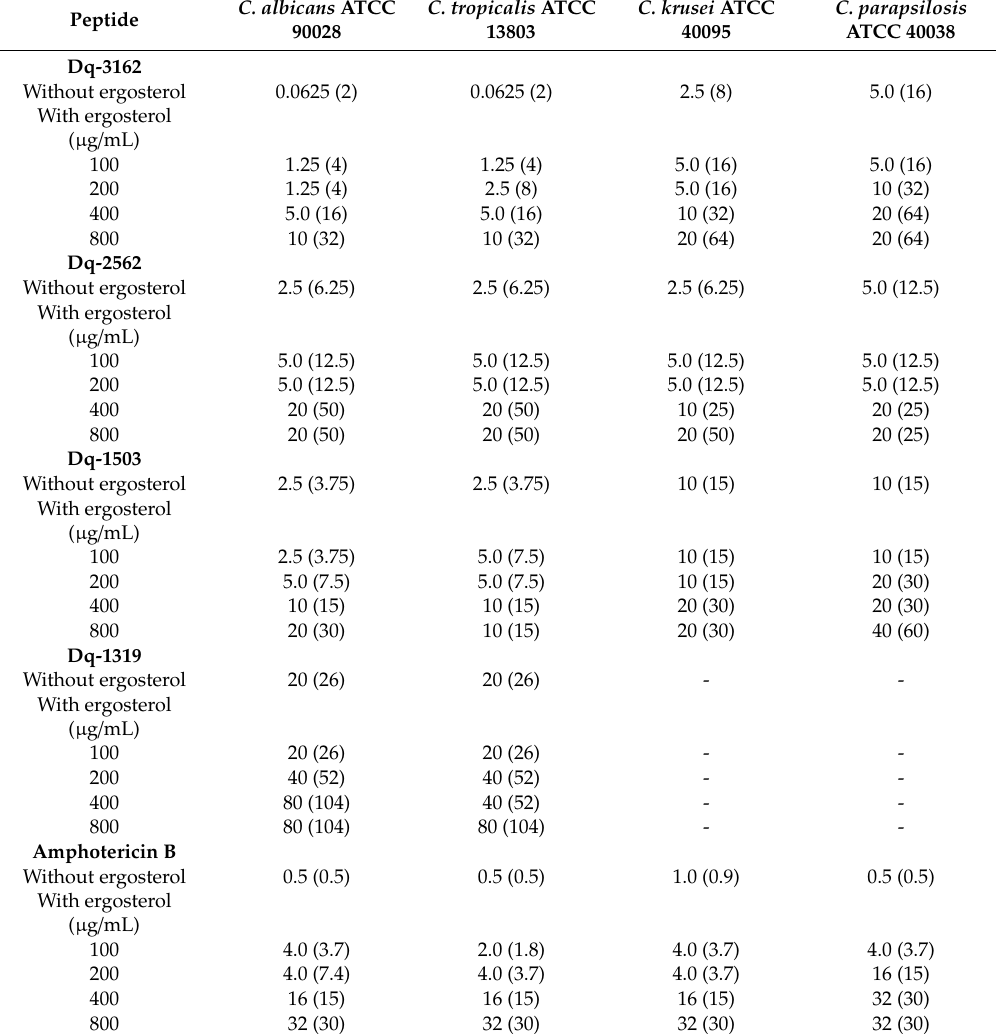
Table 5. The e ff ect of soluble ergosterol in the culture medium on the minimum inhibitory concentration (MIC) of pilosulin- (Dq-2562, Dq-1503, and Dq-1319) and ponericin-like (Dq-3162) peptides for pathogenic